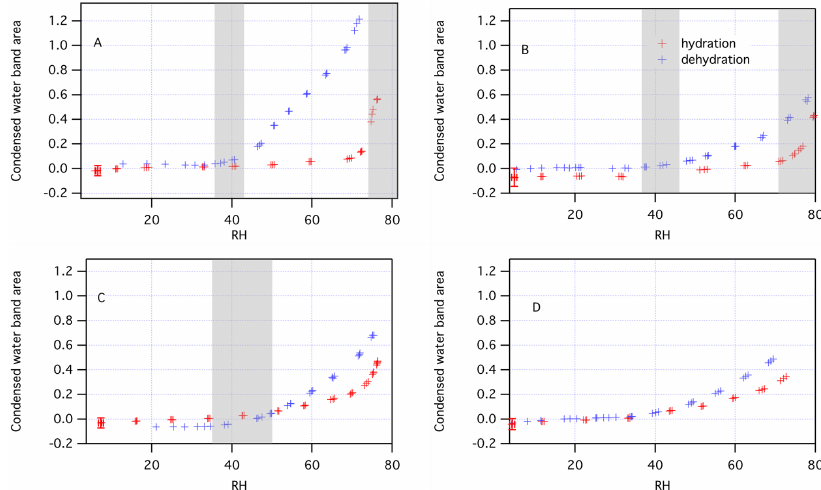
Figure 8. Deliquescence and efflorescence experiments on (NH 4 ) 2 SO 4 /1,2,6-hexanetriol/water ternary mixtures of variable concentrations. (a) Pure ammonium sulfate. Note, efflorescence at ∼ 35% RH, deliquescence at ∼ 80% RH. (b) 1 : 3 1,2,6-hexanetriol / (NH 4 ) 2 SO 4 . Note, efflorescence at 40% RH, deliquescence at 70–80% RH. (c) 1 : 2 1,2,6-hexanetriol / (NH 4 ) 2 SO 4 . Note, efflorescence at 40–50% RH, no clear deliquescence point. (d) 1 : 1 1,2,6-hexanetriol / (NH 4 ) 2 SO 4 . Note, no clear efflorescence or deliquescence